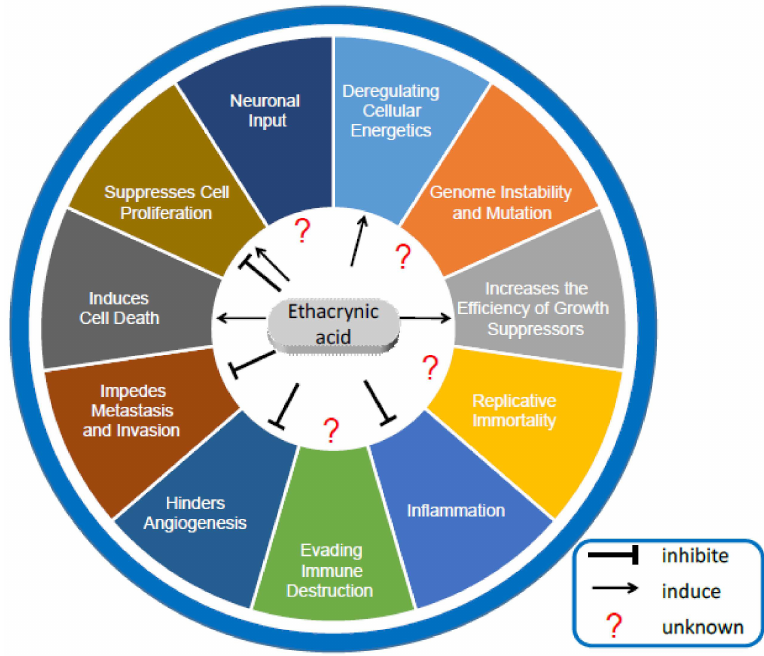
Figure 2. Effects of ECA on hallmarks of cancer.